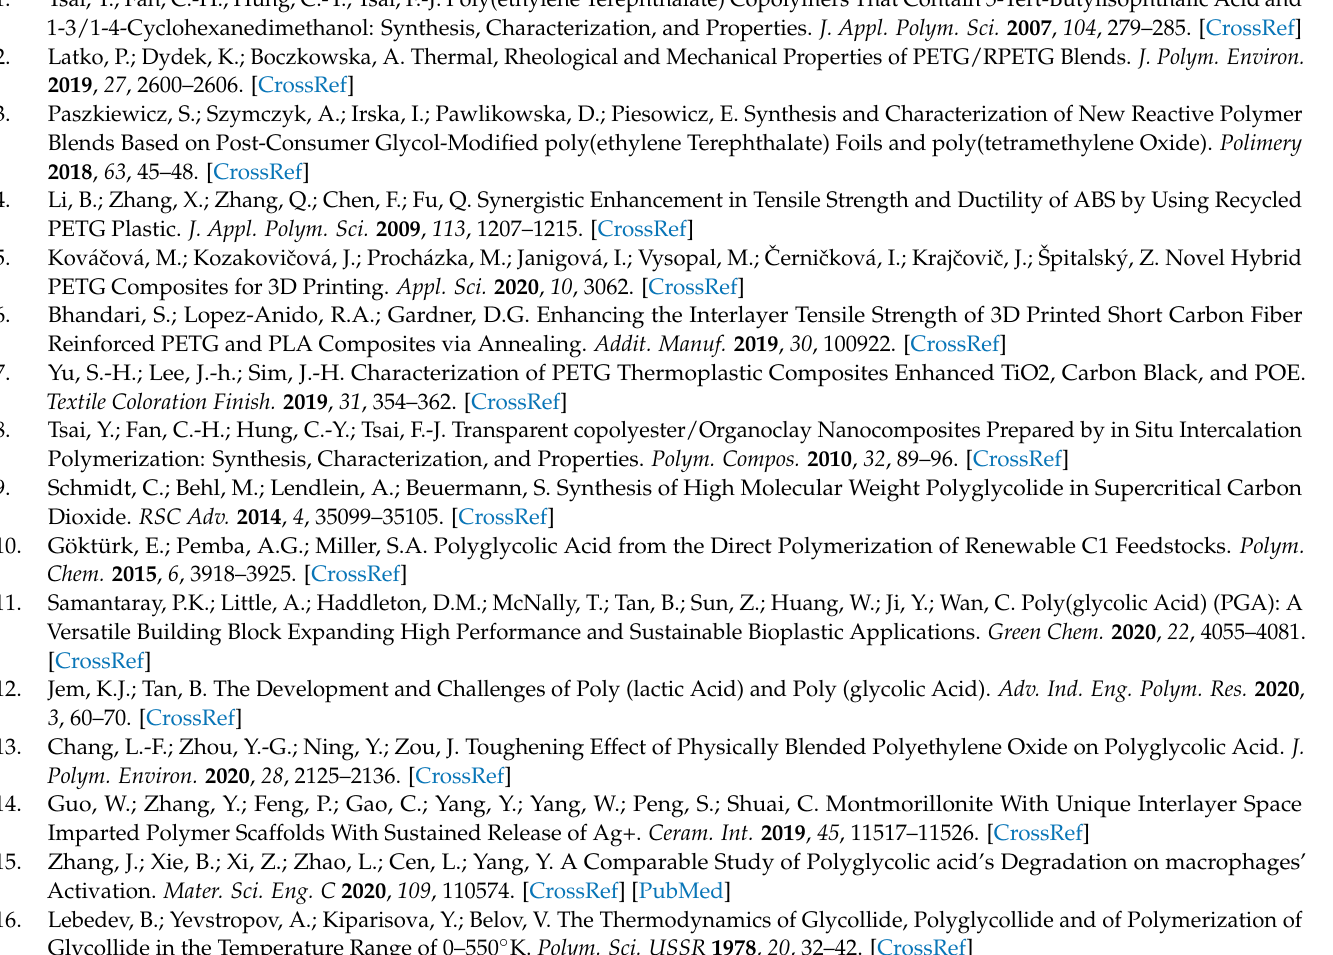
Table 10: tipa Phonetic